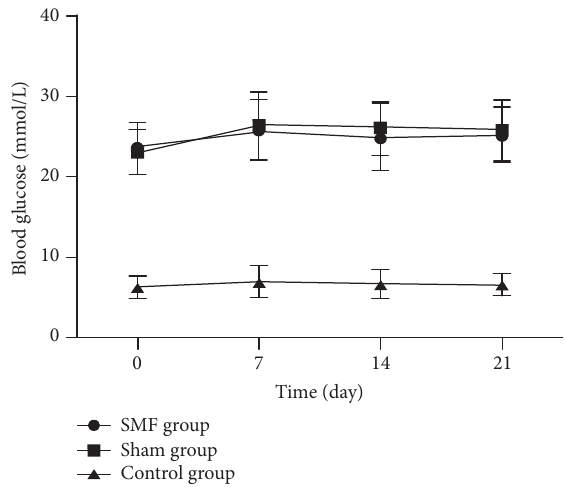
Figure 1: Trends of blood glucose levels in Control, SMF and Sham groups on days 0, 7, 14 and 21 after surgery.